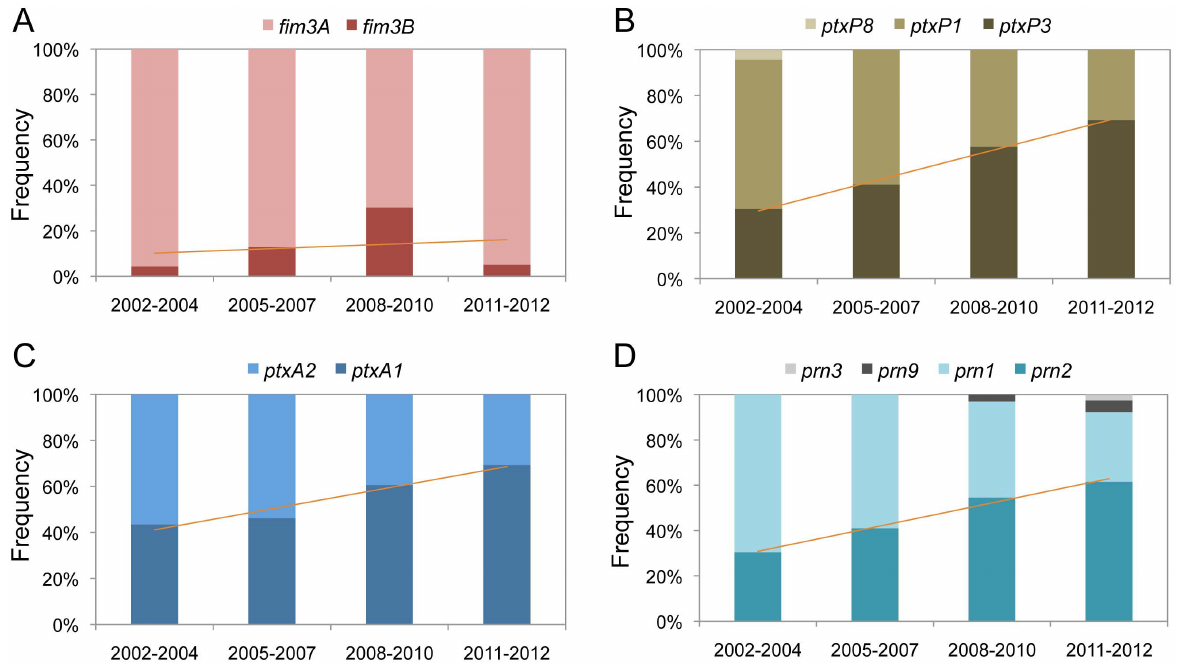
Figure 2. Temporal trends in the frequencies of fim3 , ptxP , ptxA , and prn alleles within Bordetellapertussis isolates in Japan from 2002 to 2012. Four allelic genes, fim3 (A), ptxP (B), ptxA (C), and prn (D), of 134 B.pertussis isolates were sequenced. Isolate allele frequencies are shown by time period: 2002 2 2004 (non-epidemic, n=23), 2005 2 2007 (pre-epidemic, n=39), 2008 2 2010 (epidemic, n=33), and 2011 2 2012 (post-epidemic, n=39). The regression line shows the relationship between the frequency of virulence-associated allelic variant ( fim3B , ptxP3 , ptxA1, or prn2 ) and the 4 time periods.